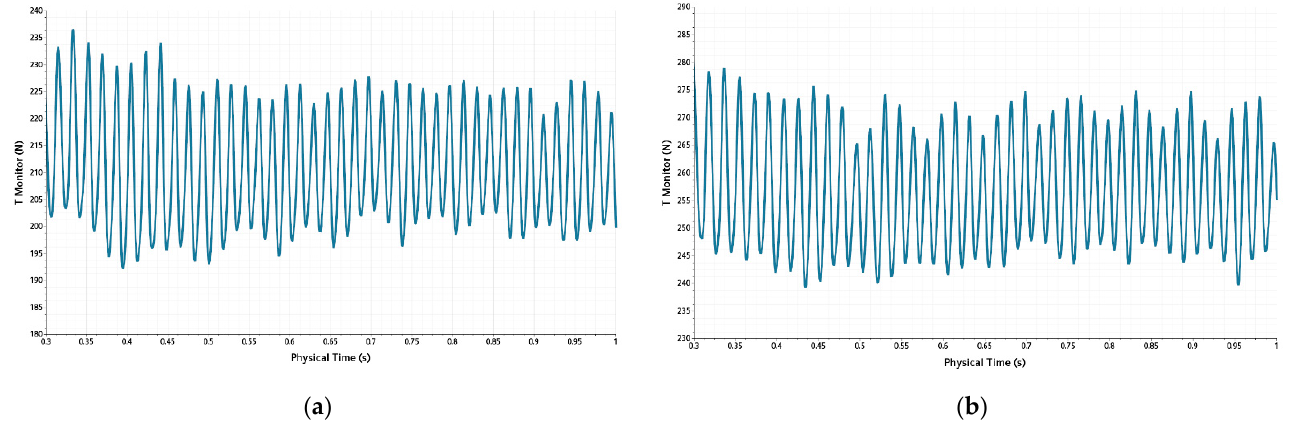
Figure 20. Comparison of unsteady forces curve of pump-jet propulsion system: ( a ) unsteady force curve of parent pump-jet propulsion system; ( b ) unsteady force curve of optimized pump-jet propulsion system.